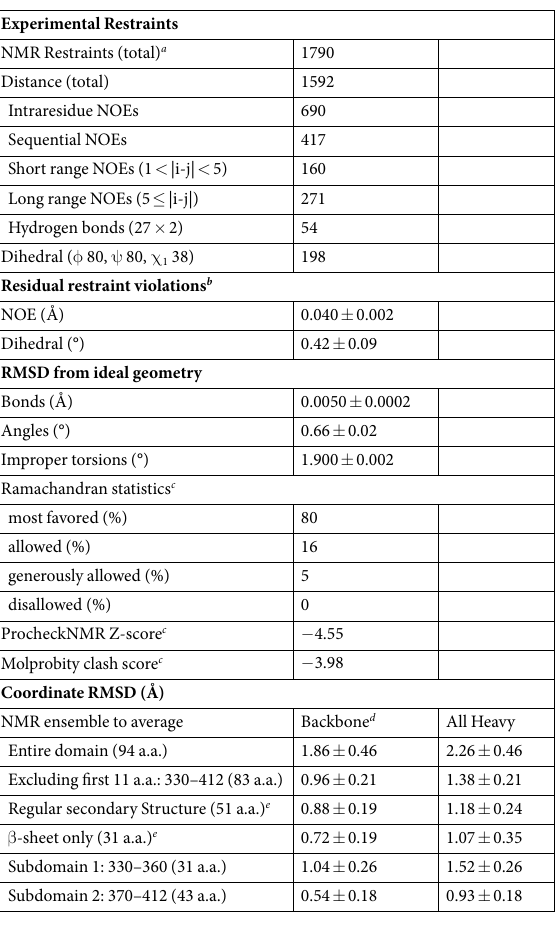
Table 1. Statistics for the 25 Lowest Energy NMR Structures of HlyIIC. a Grouping of non-redundant restraints was performed using the program QUEEN (http://www.cmbi.ru.nl/software/queen) 58 . b Structures have no NOE violations greater than 0.3 Å or dihedral angle violations more than 5°. c Calculated using the Protein Structure Validation Suite (http://psvs-1_5-dev.nesg.org) 59 . d Calculated using C ′ , N, and C α backbone atoms. e The regular secondary structure of the HlyIIC domain is 330–338 ( α A), 344–350 ( β 1), 353–359 ( β 2), 371–376 ( β 3), 379–385 ( β 4), 390–400 ( α B), 408–411 ( β